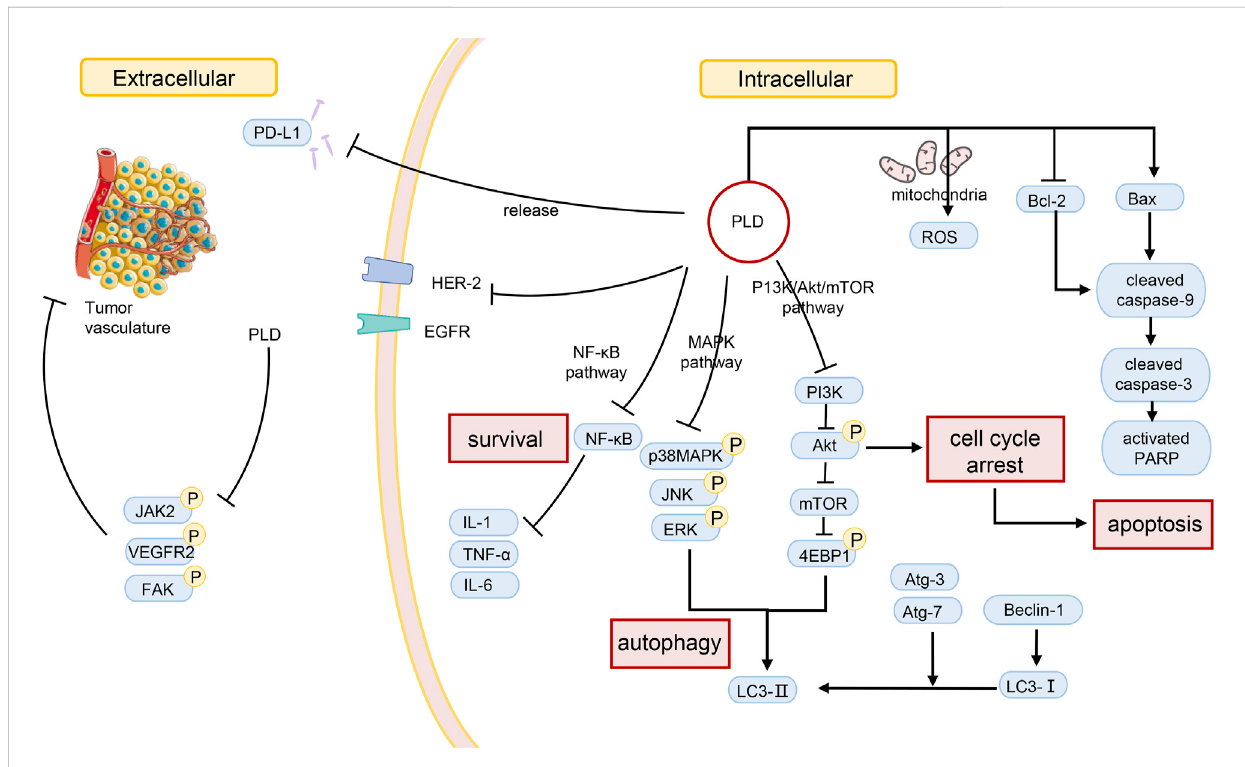
FIGURE 2 Possible mechanisms of PLD in anti-tumor